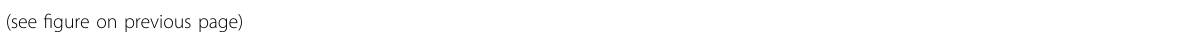
Fig. 3 Characterization of the full-polarization trapezoid conformal-skin cloak under normal incidence. a Photograph of the fabricated sample with the magni fi ed picture and phase pro fi le along the centered x axis shown in the inset. Here, the phase pro fi le is given only for half-cloak on xz plane since it is symmetric about the x axis for the left-half counterpart. The trapezoid bump is with a tilt angle of ψ = 22.5 o and a cross section of L × H = 387 mm × 50.5 mm. There are totally 24 meta-atoms on each slope, 26 meta-atoms on the top side along the x direction, while 40 meta- atoms along the y direction ( P = 220 mm) of the cloak. b Measured NF E x distributions of the bare bump under σ x j i ( b ). c – f Measured NF E - fi eld (cid:1) (cid:3) (cid:1) distributions (copolarized component) of cloaked bump under σ x j i ( c ), σ y ( d ), σ (cid:2) j i ( e ), and σ þ j i ( f ) at 15.5 GHz. g Comparison of copolarized FF scattering patterns on linear scale of 0 – 1 between FDTD simulations and experiments at 15 GHz on the xz plane for both cloaked bump under σ x j i , (cid:1) (cid:1) (cid:3) (cid:3) (cid:1) (cid:1) σ , σ π = 4 , σ (cid:2) j i , and σ þ j i , respectively, and bare metallic bump of the same size under σ x j i . Here, all NF and FF results are normalized to their y respective maximum with identical units and scales. The cloak sample is designed using a computer-aided design (CAD) process and prepared based on a four-step dual-sided fabrication process by combining 3D-printing and fl exible printed circuit board (PCB) technique, see Sample preparing and fabrication in Methods. The commonly available 0.1-mm-thick F4B board with ε r = 2.65 and tan δ = 0.001 is utilized as the fl exible thin substrate and backed ground. By taking the stability and rigidity into consideration, the 2.5-mm-thick polymer ABS - M30 with ε r = 2.7 and tan δ = 0.005 is chosen as the 3D-printing material to preserve the perfect shape of the supporting platform, and thus hold the well-designed phase pro fi